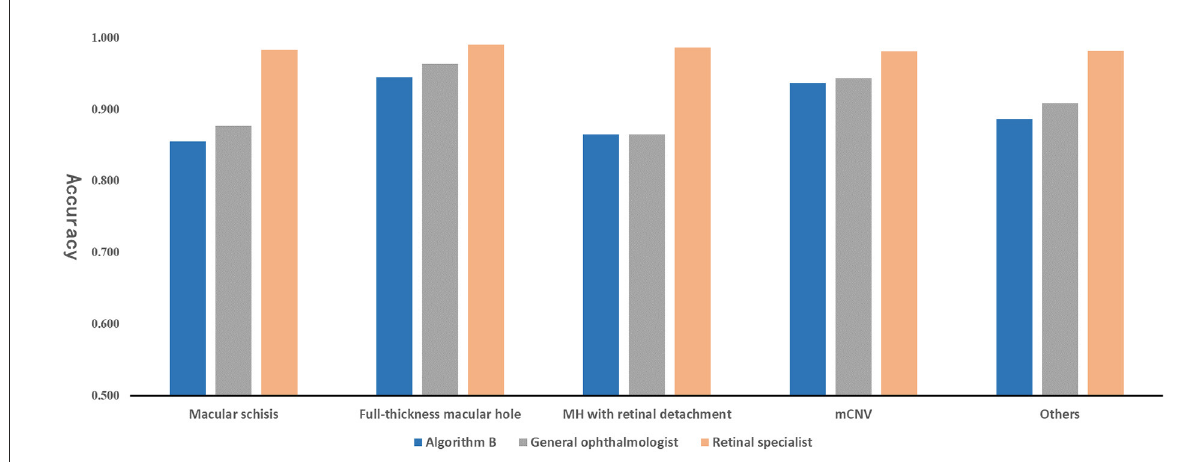
FIGURE7 The comparison between algorithm B and experts on accuracy in external validation.